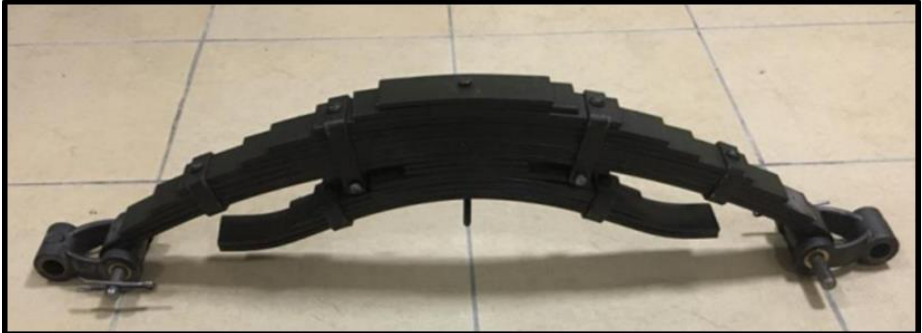
Figure 2. The leaf spring system used in the designed experimental system’s main components of a leaf spring system.